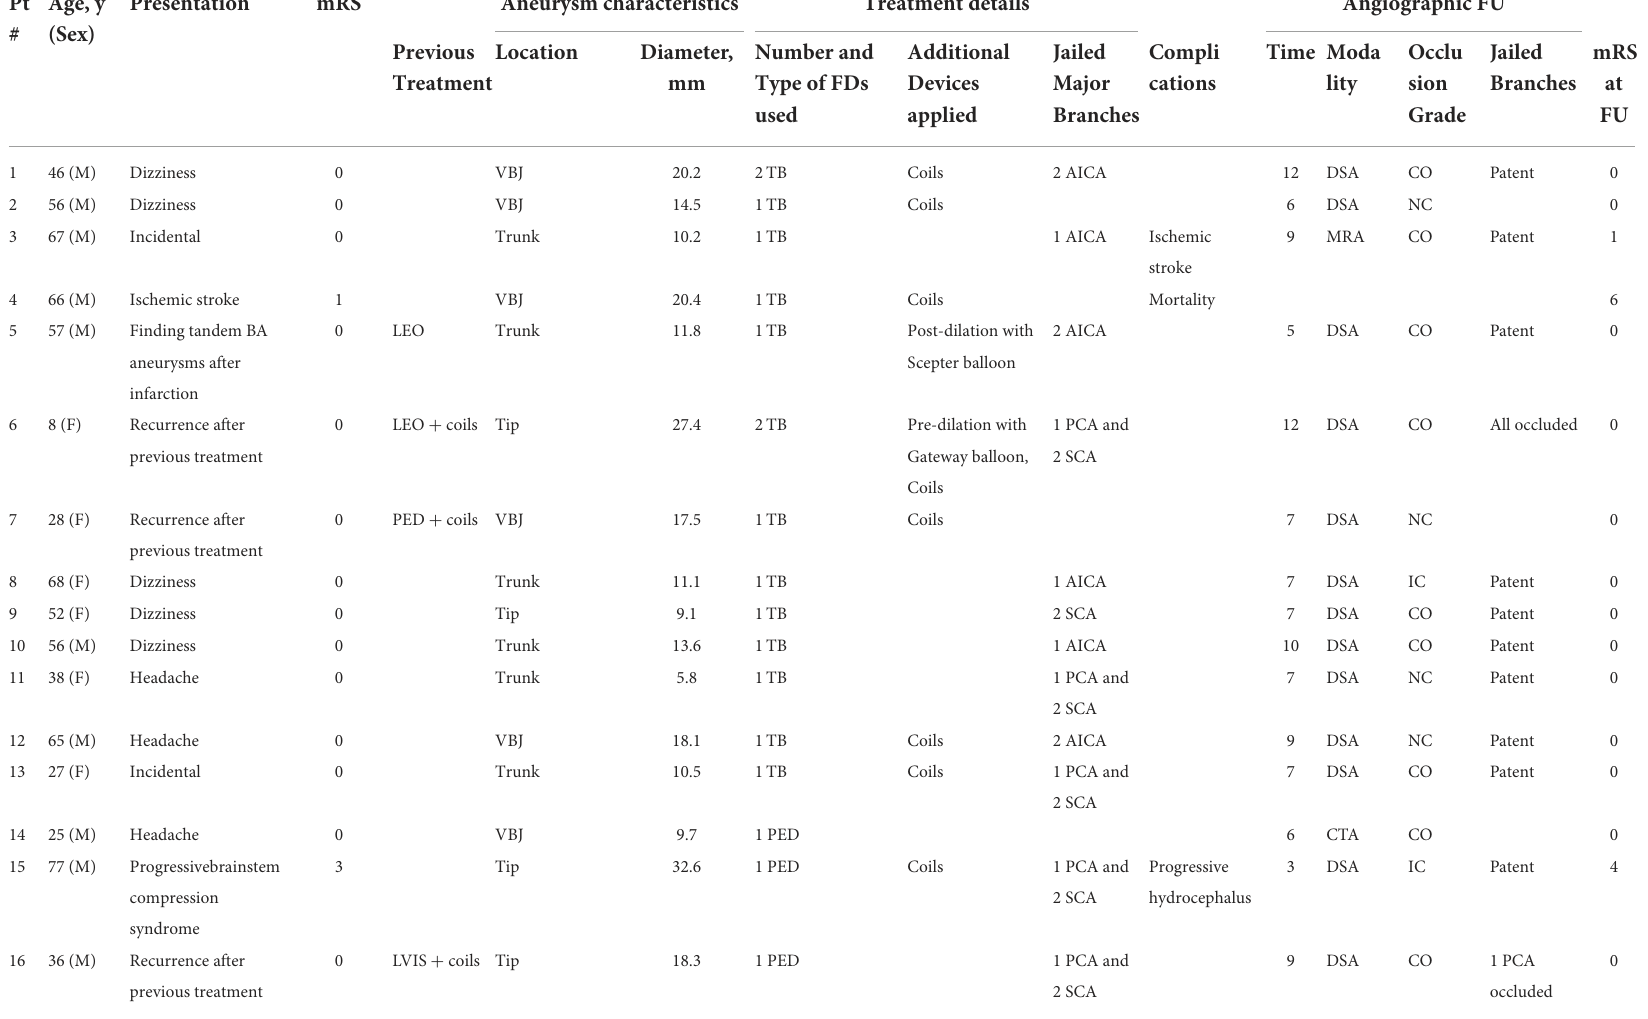
TABLE 1 Patient demographics, aneurysm characteristics, and treatment